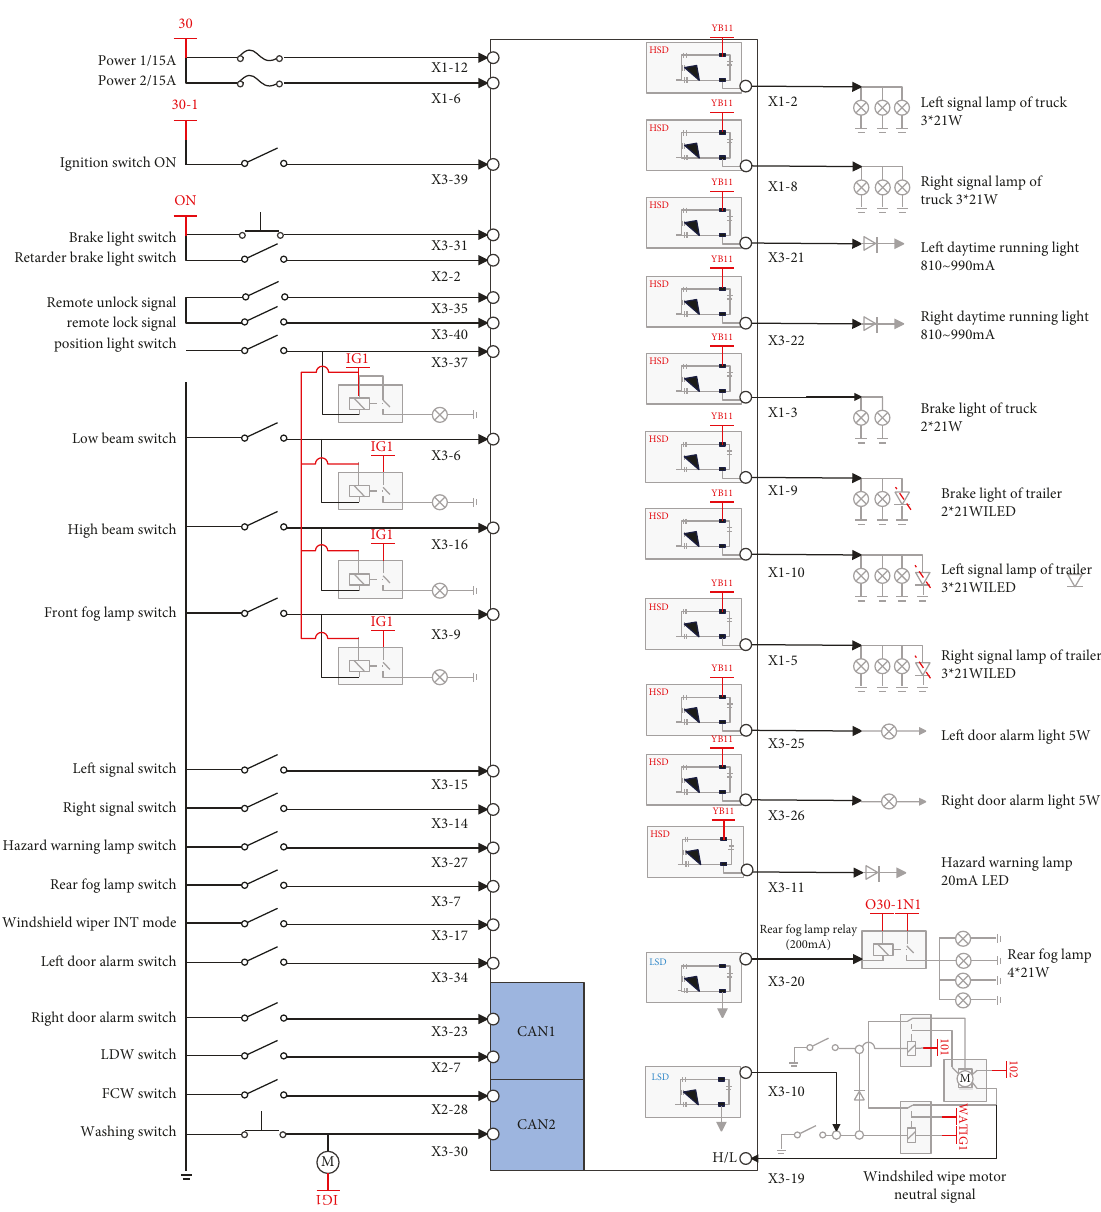
Figure 6: Schematic diagram of the body controller